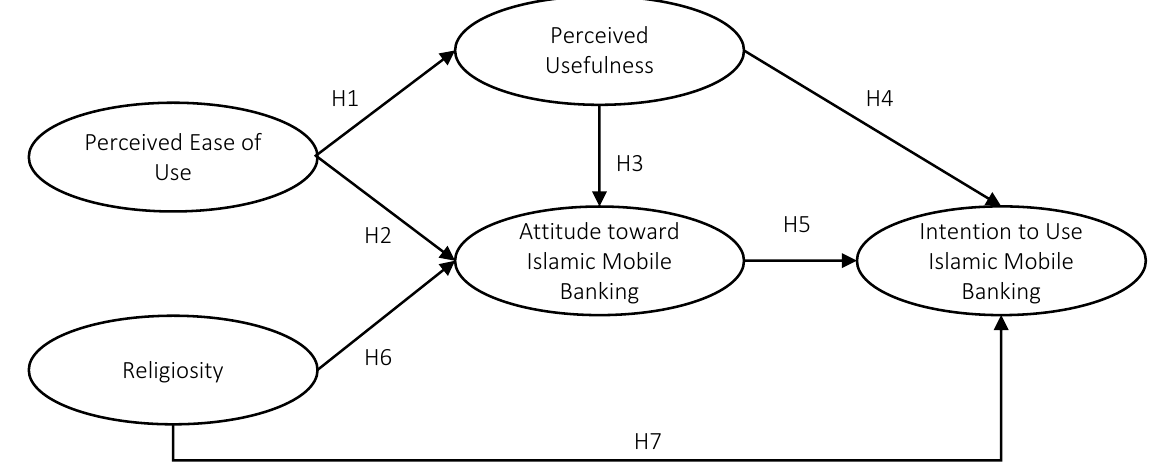
Figure 1. Conceptual research